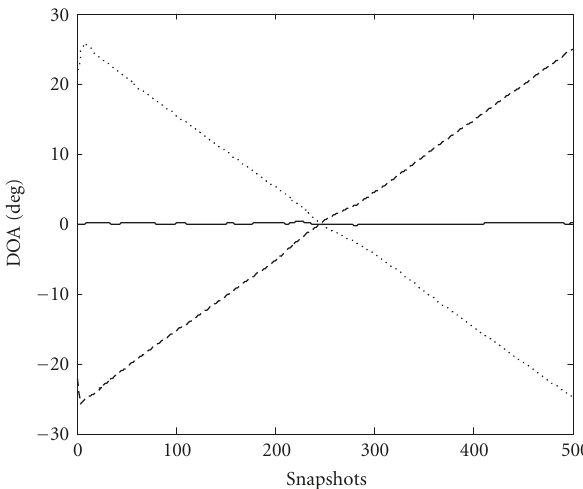
Figure 11: Estimated trajectories of the three crossing-over targets versus number of snapshots.